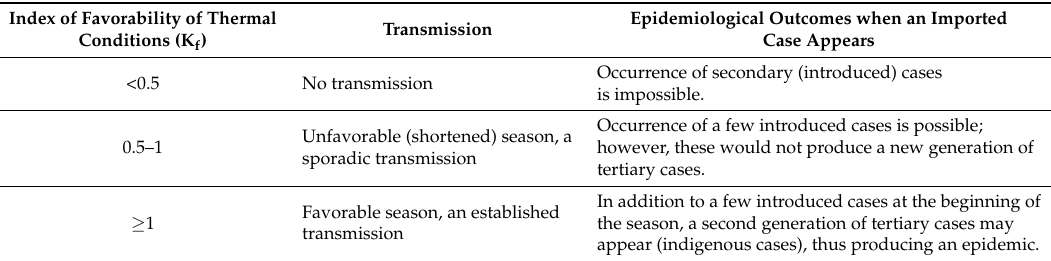
Table 1. The extent of favorability of meteorological conditions for autochthonous transmission of malaria.